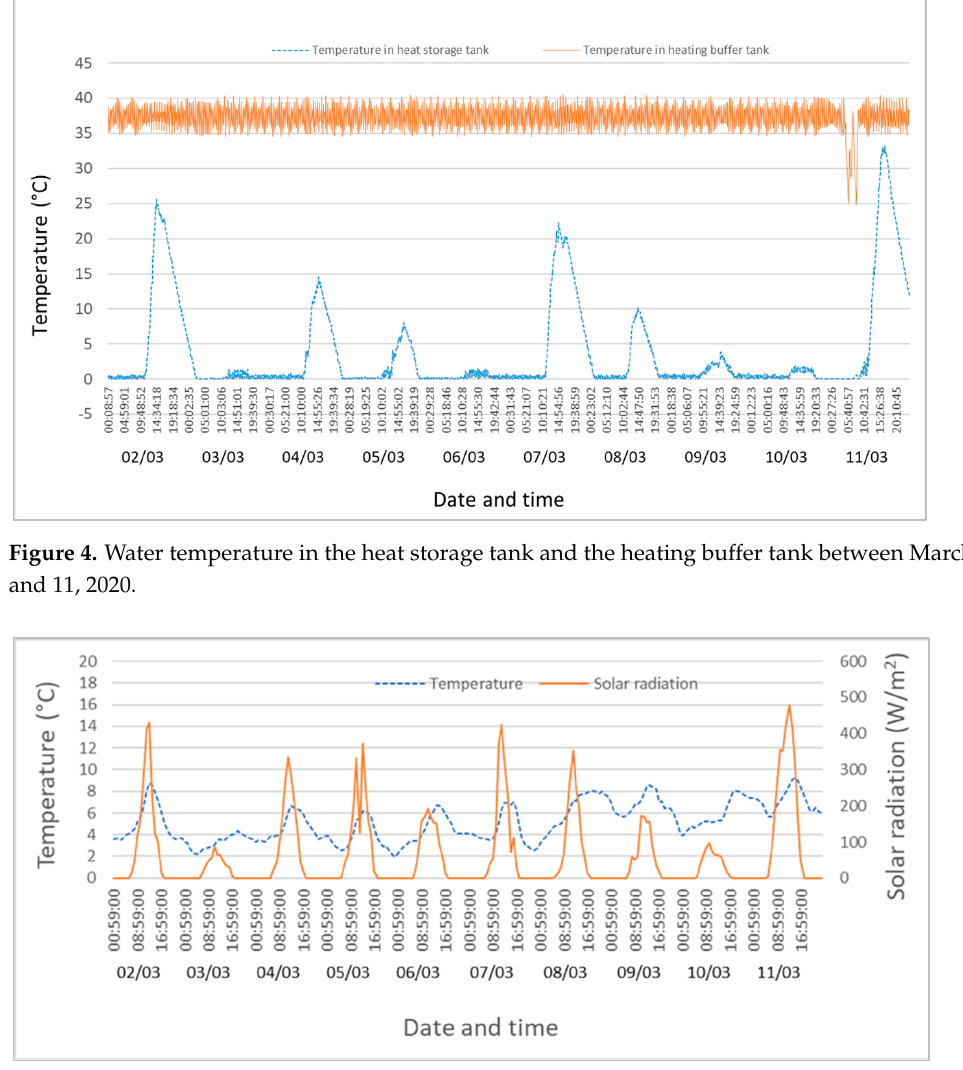
Figure 4. Water temperature in the heat storage tank and the heating buffer tank between March 2